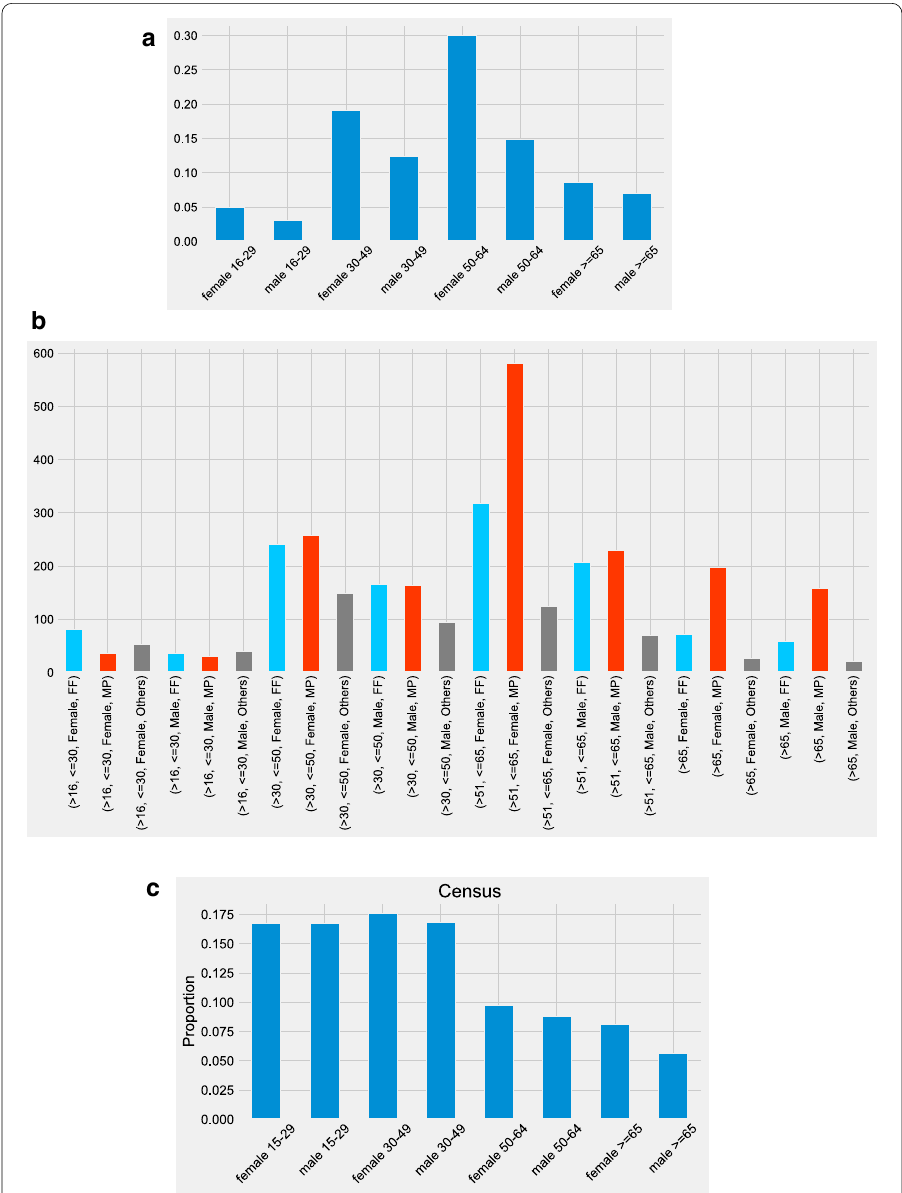
Fig. 2 a Elypsis polls demographic distribution of respondents to survey conducted before the primaries (PASO) by age and gender. b Elypsis polling results before PASO separated by age and gender (Macri Fernández blue, Others grey). Results are highly biased to people older than 50 as compared with = = the Census distribution in panel c . c Argentina Census Bureau 2010 demographic distribution by age and gender used to compare the demographics of the polls and the Twitter